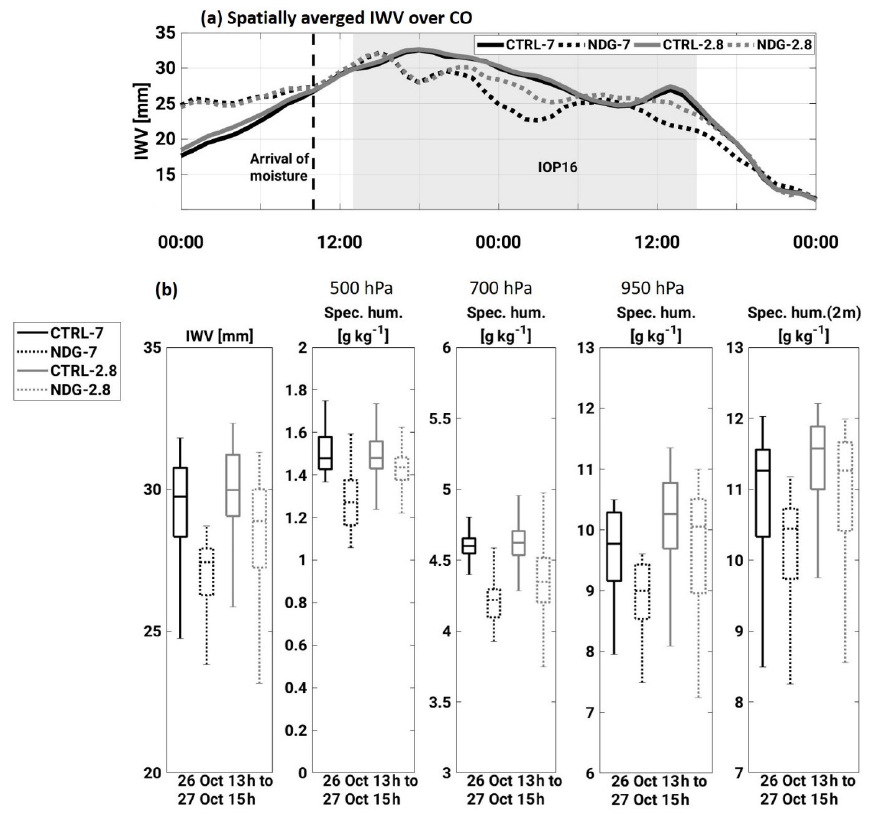
Figure 9. Spatially averaged IWV for all simulations during the event. The area for averaging is shown in Fig. 1 (CO), and the model output has been upscaled to a common coarser grid. The period shown is 26 October at 00:00UTC to 28 October at 00:00UTC. (b) Box-and-whisker plots showing the median, the 25th and 75th percentiles and the extreme values of IWV and specific humidity at 500, 700 and 950hPa and at 2m height. The box and whiskers are obtained from the distribution of values for the quantities shown between 26 October at 13:00UTC and 27 October at 15:00UTC over the study region CO.